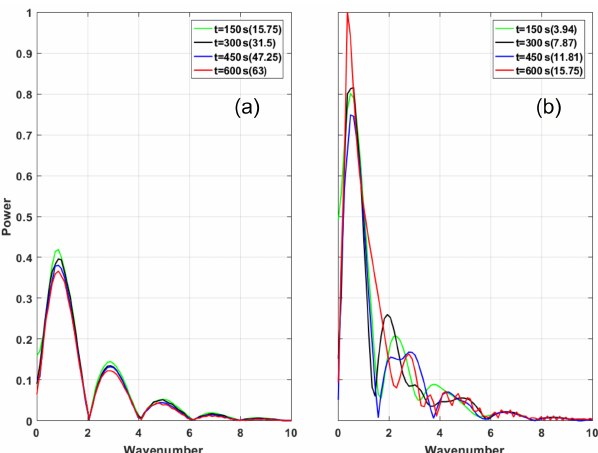
Figure 4. A comparison of how the horizontal velocity spectra for the Ro = 0 . 5, f = f 0 , and w = w 0 case (a) and the Ro = 2, f = 1 f 0 , and w = w 0 case (b) change over time. The spectral 4 power has been scaled by the maximum between the cases to high- light the differences. The green line corresponds to t = 15 . 75 and t = 3 . 94, the black line to t = 31 . 50 and t = 7 . 87, the blue line to t = 47 . 25 and t = 11 . 81, and the red line to t = 63 and t = 15 . 75. There are clear changes in the spectra for the weakly rotating case as the waves evolve. In the strong rotation case the only temporal differences are a slow decay. The differences seen in the weakly ro- tating case highlight the nonlinear effects which are present in this